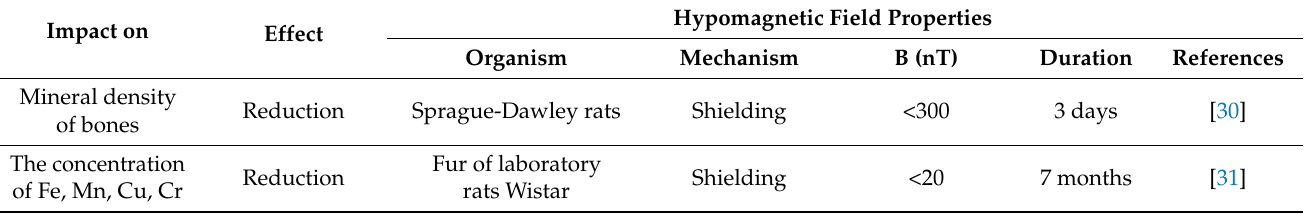
Table 1. Impact of hypomagnetic field on cell transport and metabolism (B—magnetic flux density in Tesla